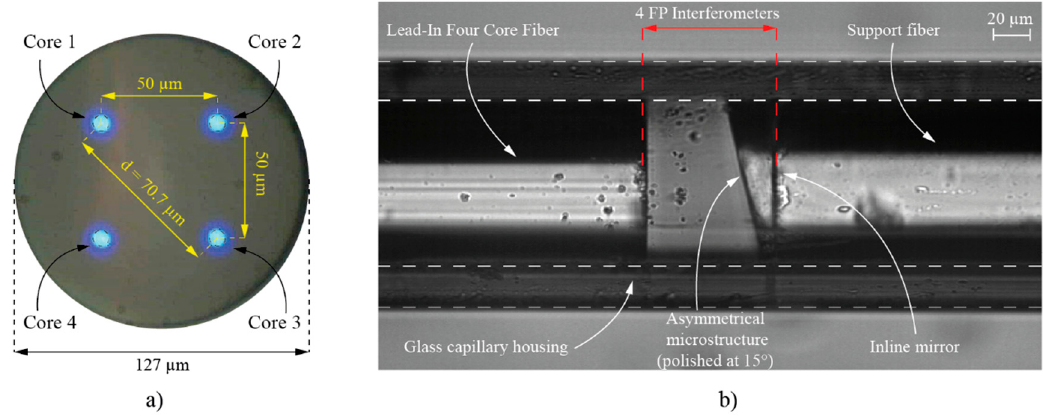
Figure 2. ( a ) Cross-section view of the four-core fiber and ( b ) Sensor assembly.